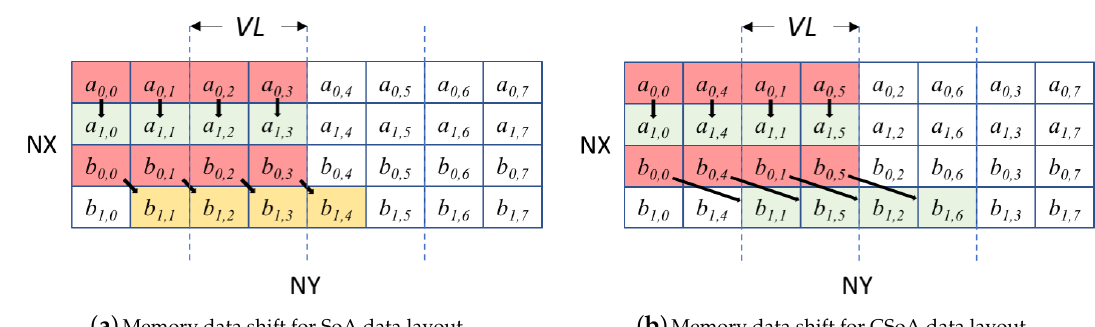
The figure shows the data shift happening for the propagate kernel on a 2 × 8 two-dimensional lattice with two populations ( a and b ), using the SoA ( a ) and the CSoA ( b ) schemas, respectively. Data are considered stored in row-major order and the indexes indicating the site position in the two-dimensional lattice. In the picture the arrows describe the direction on which each given population moves. Data elements representing a specific data movement have been coloured: red for elements with correct memory alignment for the operation of reading, green for elements with a correct memory alignment for the operation of writing and finally, yellow for elements with a memory misalignment for the operation of writing. While in ( a ) only 50% of the operations of writing are aligned in memory, in ( b ) 100% of the copies of element required by the propagate kernel will result aligned in